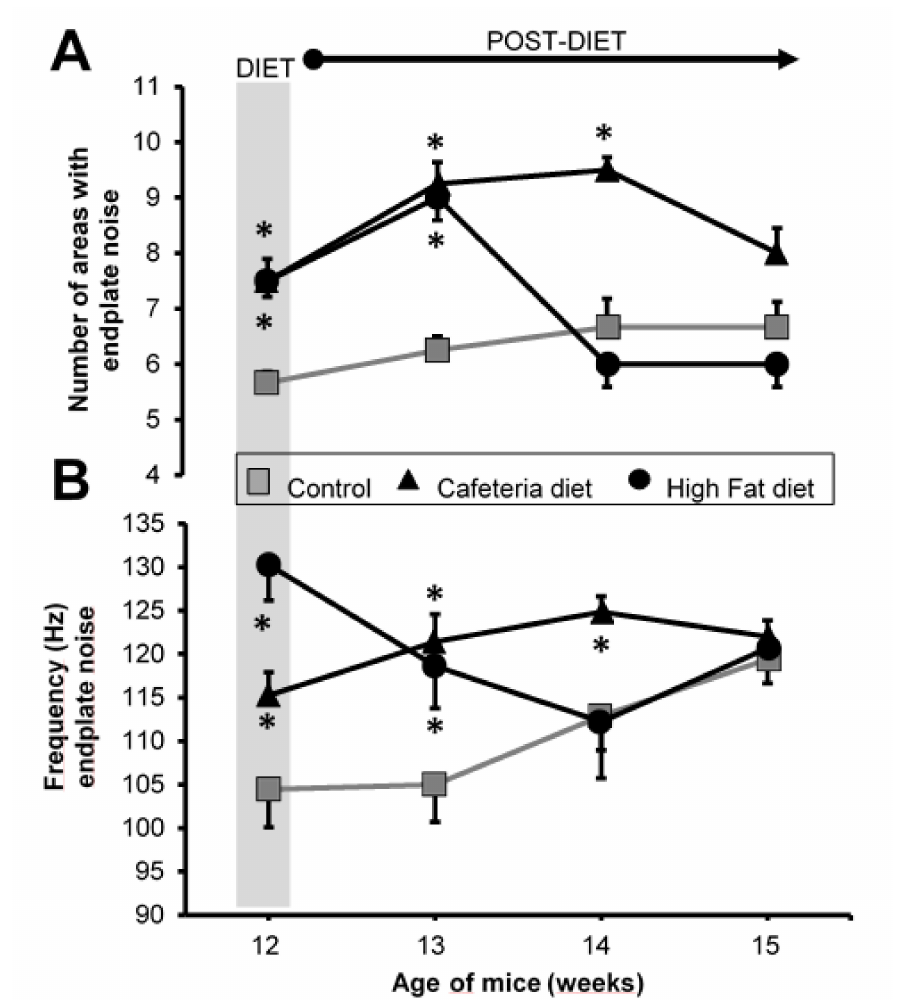
Figure 4. Electromyography. ( A ) Number of average areas with plate noise. ( B ) Each area with endplate noise was analyzed by quantifying the number of events / s (Hz). Grey area, end of the period in which the animals were exposed to the diets. Values are expressed as the mean ± SEM. For each experimental series, N = 8 gastrocnemius muscles from 4 animals. * p < 0.05 with respect to control